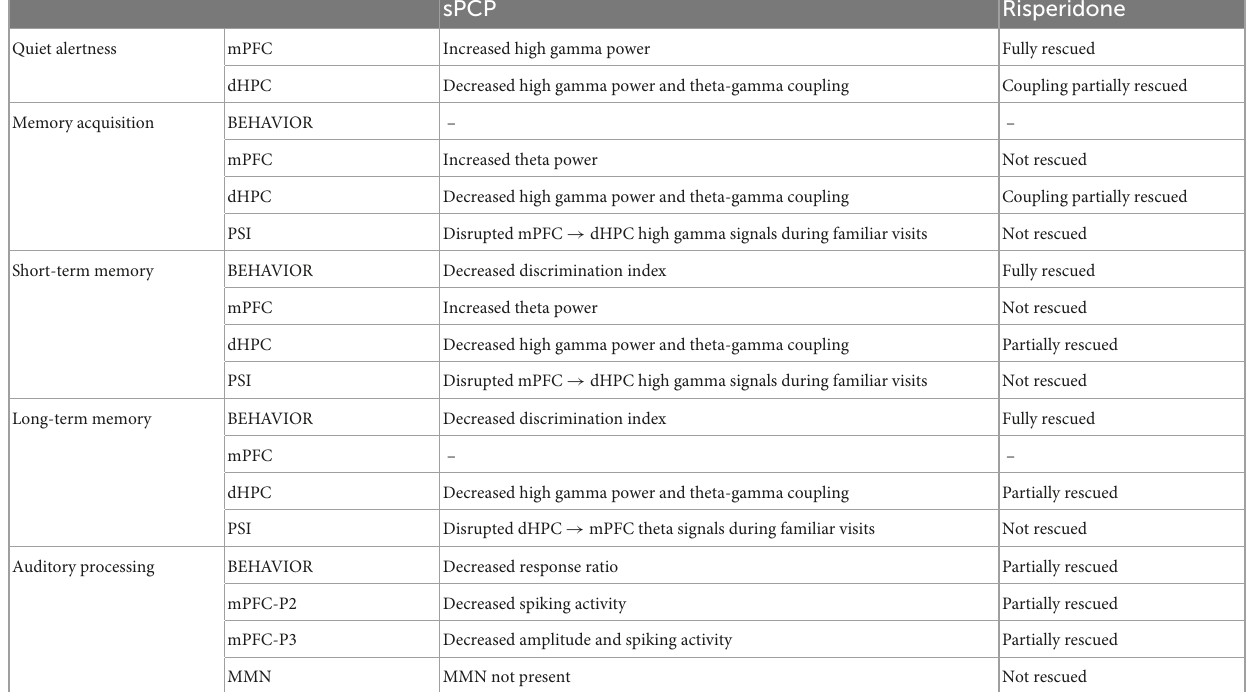
TABLE 1 Summary of main